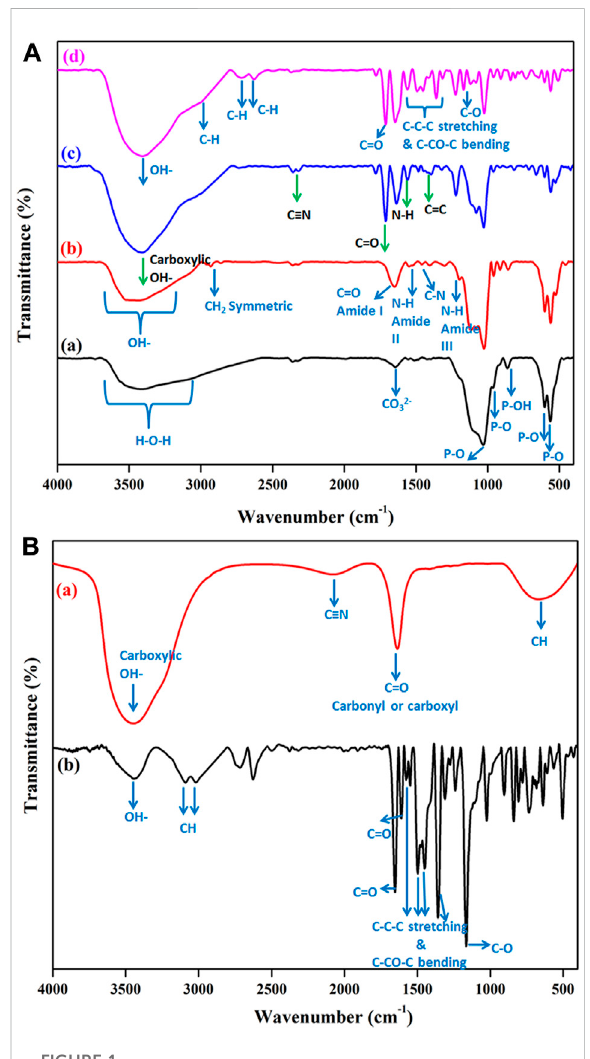
FIGURE 1 FT-IRspectraof (A)